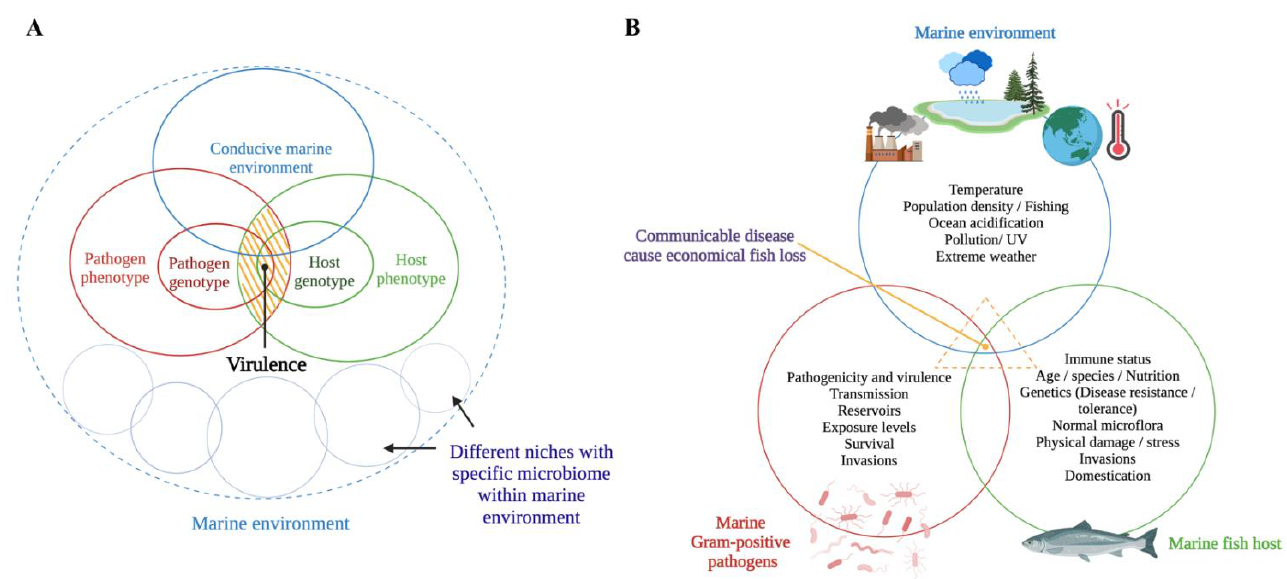
Figure 1. Schematic representations of ( A ) how virulence is modulated in a dynamic host – pathogen interaction [21] (the yellow shaded area expresses virulence as an outcome of a dynamic host-pathogen interaction in a conducive marine environment) and ( B ) how the disease process occurs as a result of complex host-pathogen-environment interactions. This figure was generated by the authors using BioRender (https://biorender.com/) (accessed on 1 August 2022).